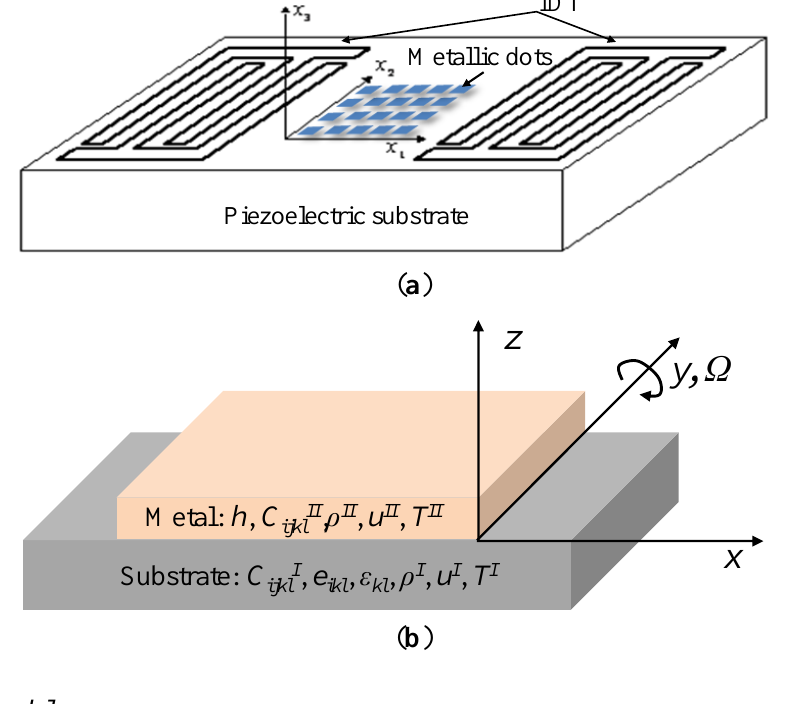
Figure 2. SAW device with metallic dot array used for gyroscope ( a ), and the coordinate system used in this study ( b